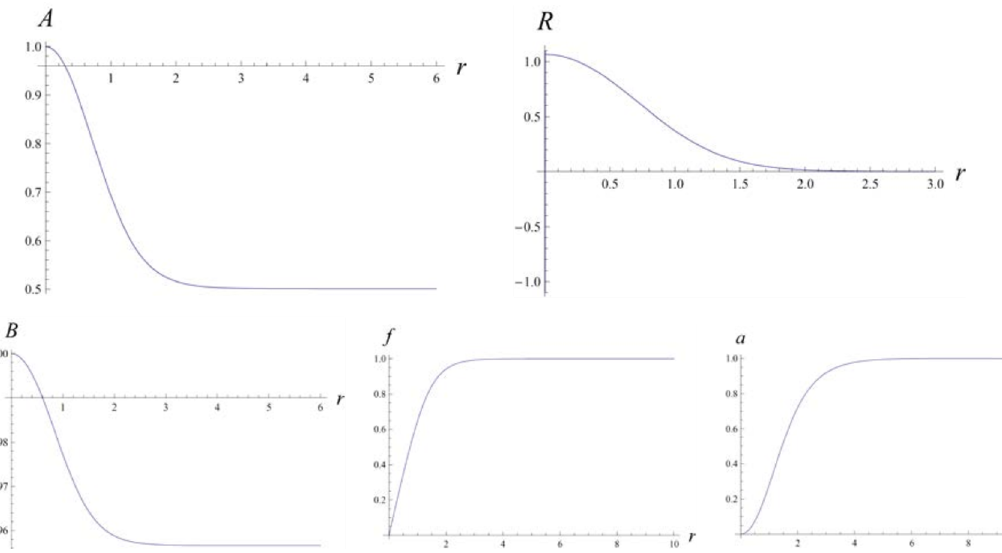
Figure 7 . Case α = 1 in asymptotically Minkowski spacetime. This is the case with the strongest gravitational coupling of the three. The Ricci scalar has the highest initial value of the three cases and the metric function A plateaus to the lowest value of D leading to the highest angular deficit. The mass is not too different from the other two cases or from the no gravity case. See table 2 for